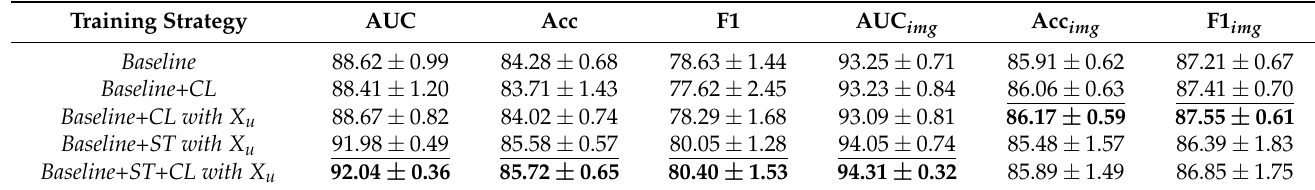
Table 3. Model performance on the BCSS dataset with different training strategies.